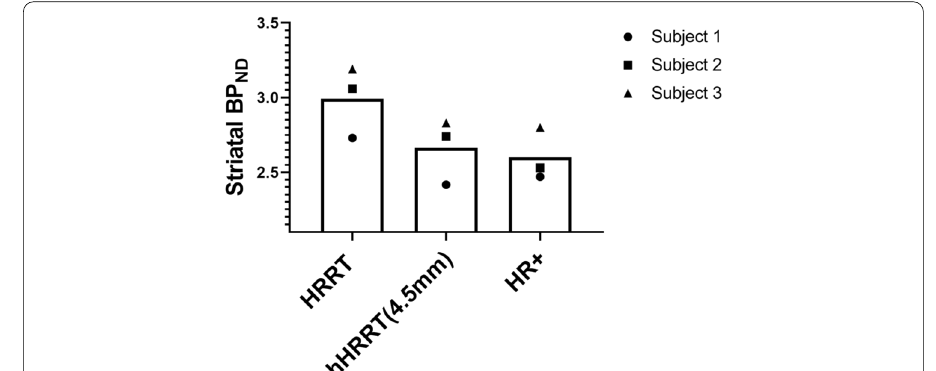
Fig. 4 Striatal BP ND for the 3 subjects HRRT, hHRRT(4.5 mm), and the HR (filled square), and Subject 3 (filled triangle) are all marked with filled shapes